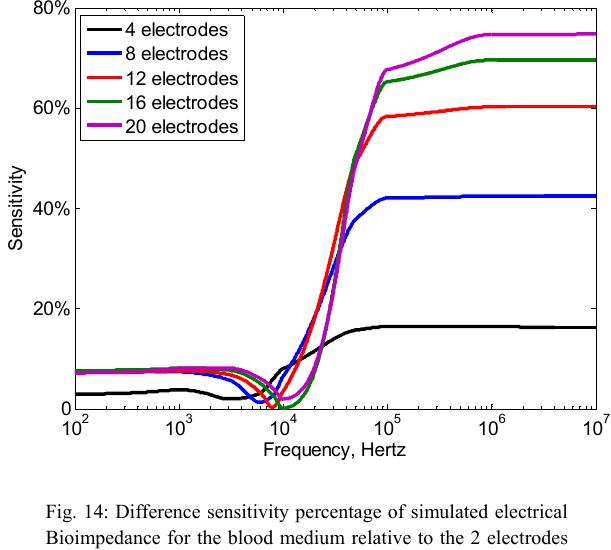
Fig. 14: Difference sensitivity percentage of simulated electrical Bioimpedance for the blood medium relative to the 2 electrodes type sensor by varying the number of electrodes N, while leaving the same contact area of sensor 1000 × 1000 microns. The sensitivity is calculated by (Zi-Z2)/ (Z2·volume), i is the number of